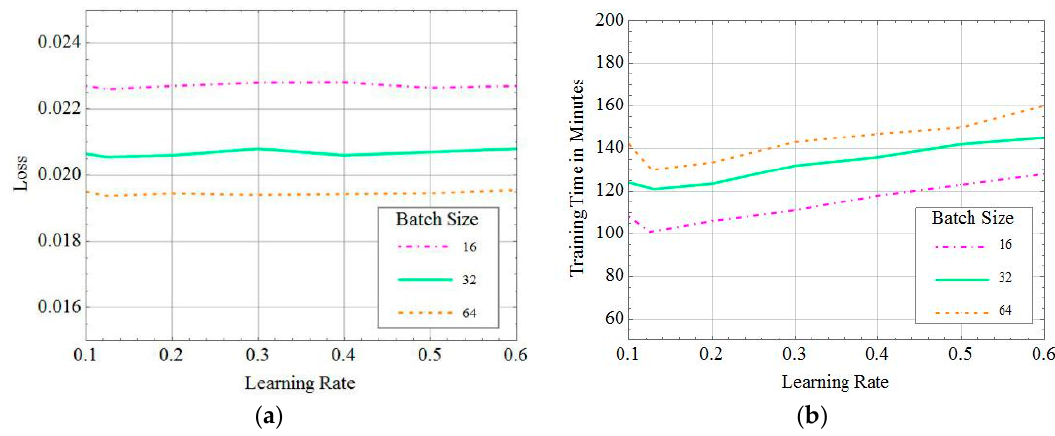
Figure 6. Effect of the learning rate and batch size on the training phase. ( a ) Effect of the learning rate and batch size on training loss. ( b ) Effect of the learning rate and batch size on training time.